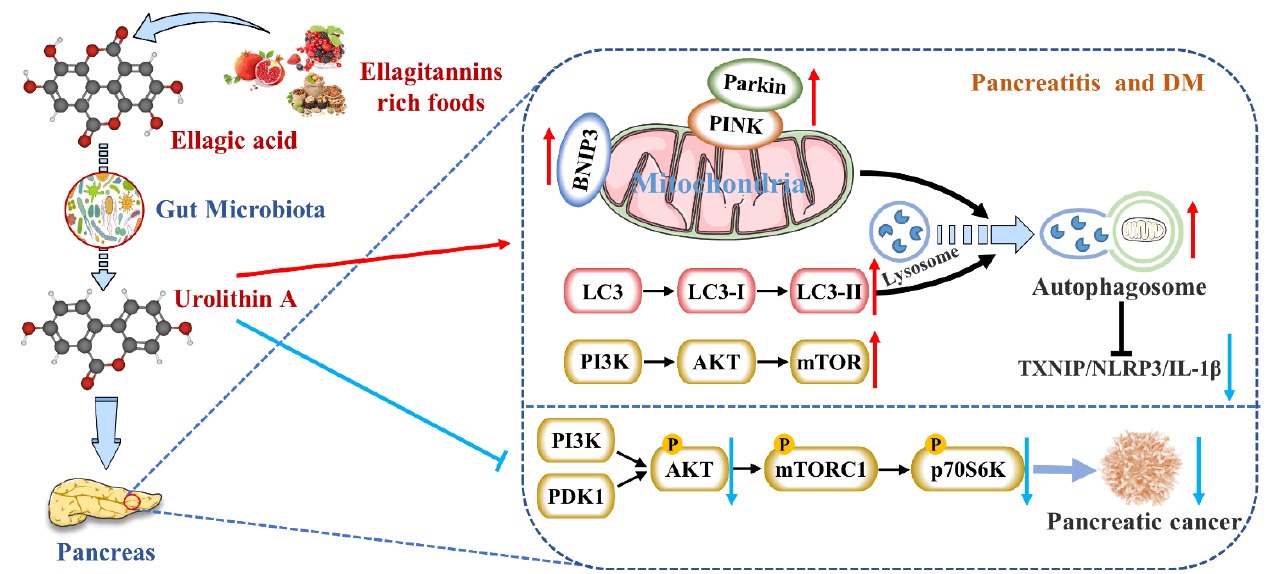
Figure 2. Uro A is metabolized by gut microbiota after ingestion of ETs and EA in mammals and has multiple potential health benefits. Uro A can attenuate pancreatic diseases by inhibiting inflammatory signaling pathways, activating autophagy, maintaining the mitochondrial function, and improving the immune microenvironment.